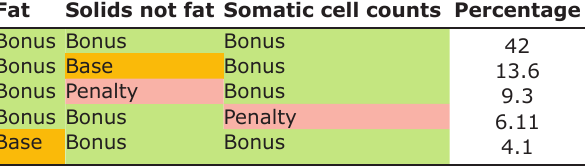
Green, yellow, and red colors indicate bonus, base, and penalty group,